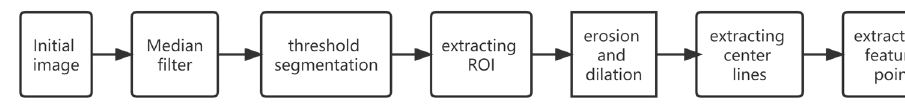
Figure 1. The traditional morphological method (TMM) process.